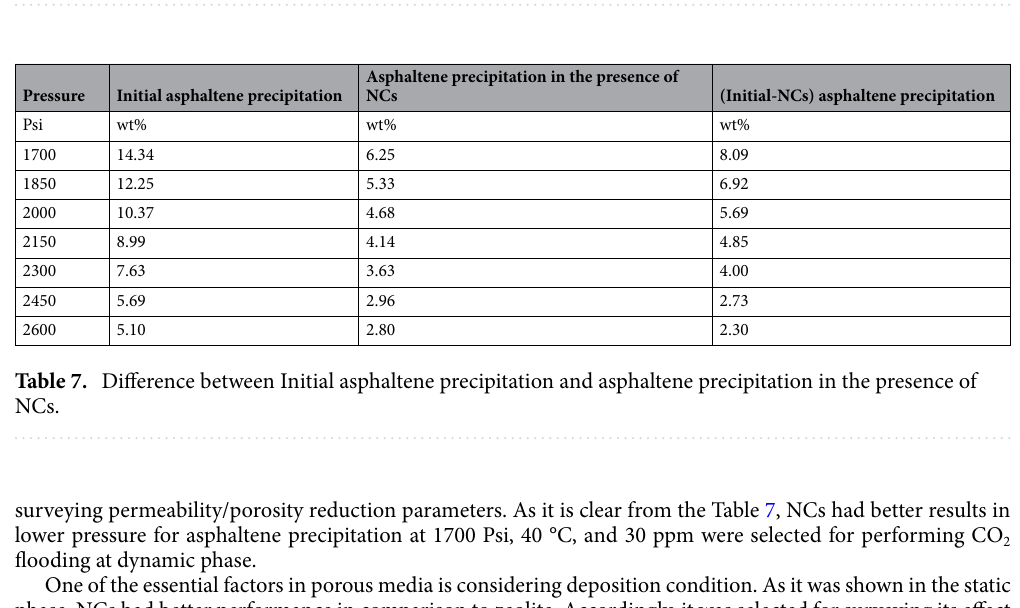
Figure 10. Effects of NCs and zeolite nanoparticles on asphaltene precipitation during natural depletion tests.